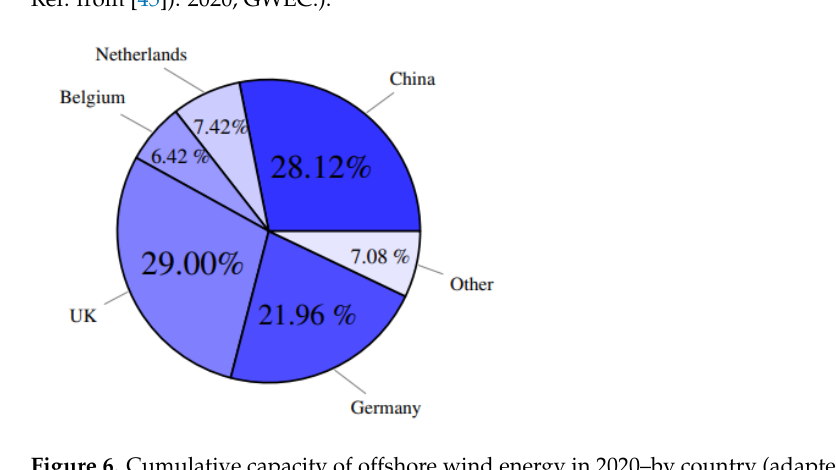
Figure 6. Cumulative capacity of offshore wind energy in 2020–by country (adapted with permission from Ref. from [45]). 2020,